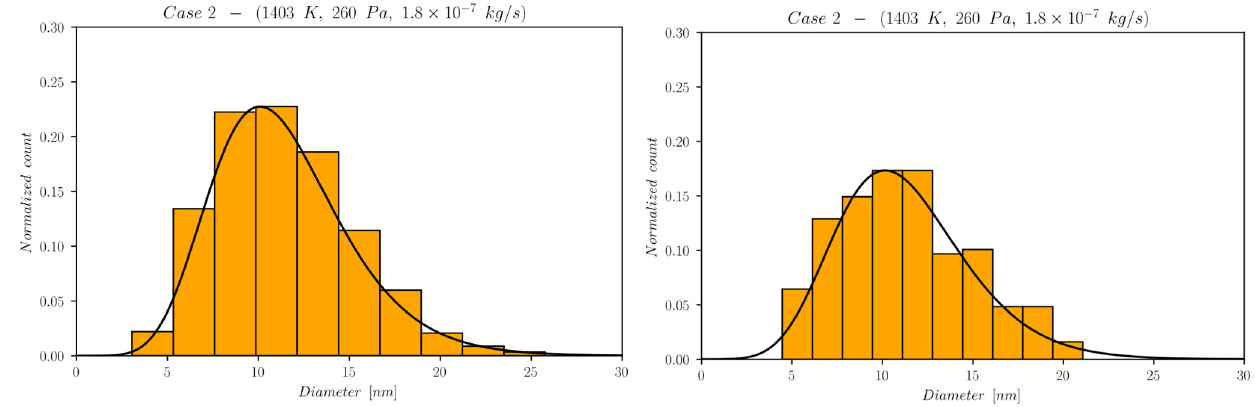
Figure 8. Final PSD for reference case 2; ( left ) PBM predictions and ( right ) experimental results.